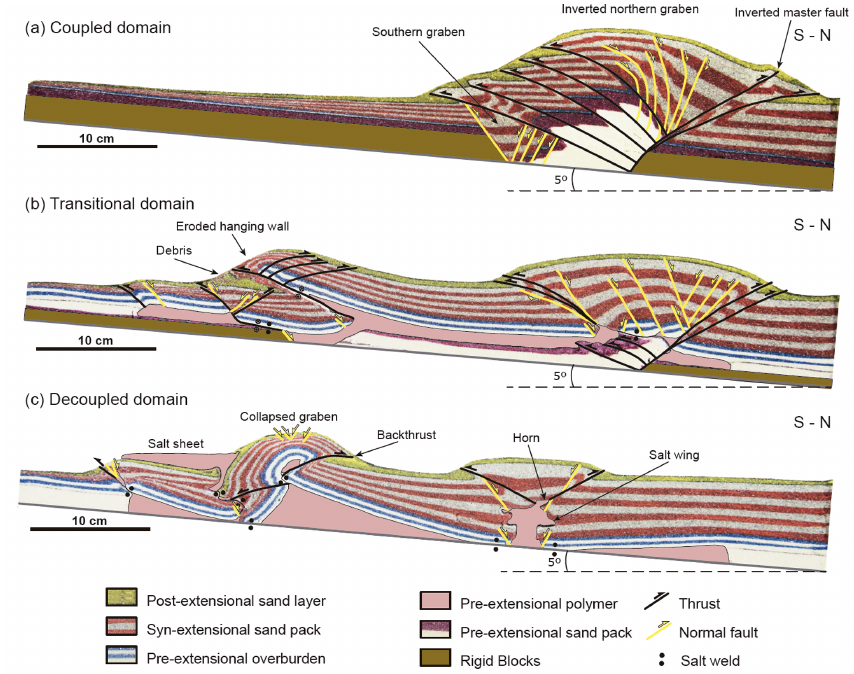
Figure 7. Cross-sections at the end of the model 2 (after 200mm of shortening) showing the structural style at the different domains. (a) Coupled domain; (b) transitional domain; (c) decoupled domain. See Fig. 6d for location. The rig was tilted to the north up to an additional 2.2 ◦ to simulate the orogenic flexure of the Basque–Cantabrian